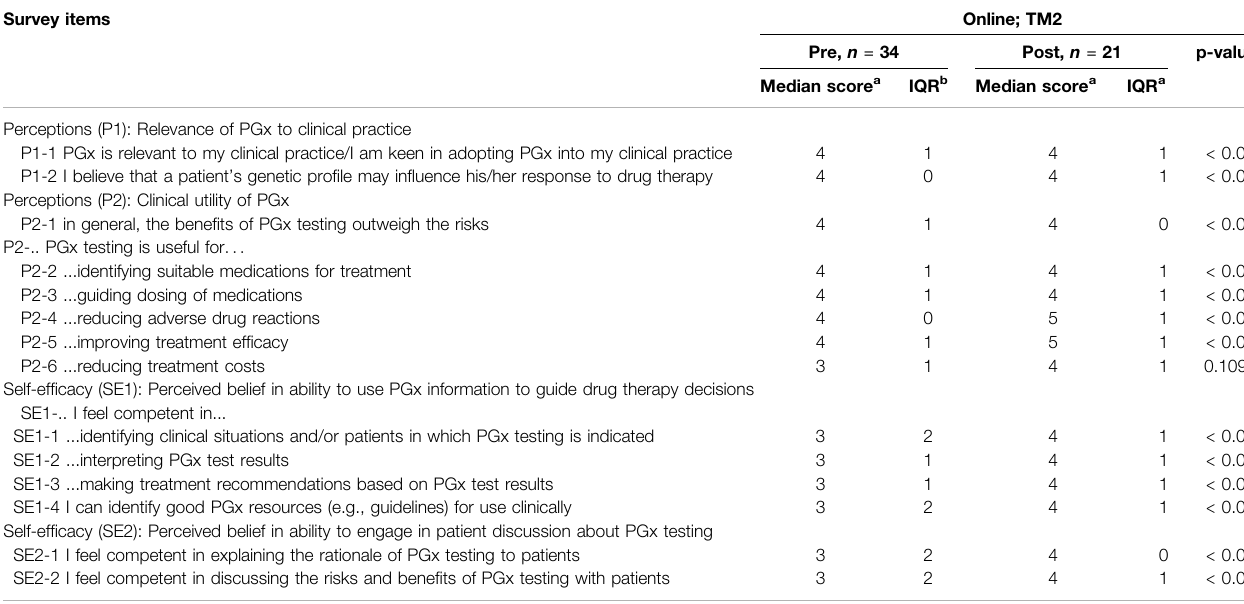
TABLE 5 | Pre- and post-online TM2 training results related to perceptions and self-ef fi cacy of addressing PGx testing. Survey items Online; TM2